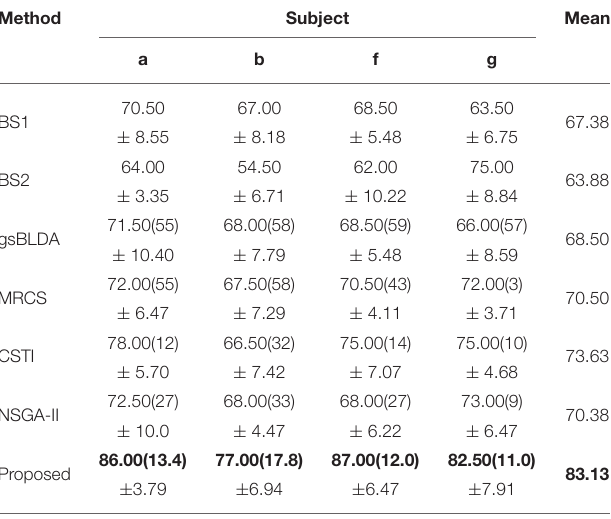
TABLE 8 | The mean classification accuracy and standard deviation (%) of 5 cross-validation with the number of corresponding channels (listed in the bracket) of COL and baselines on 4 subjects of DS2 after using REST for zero-reference.